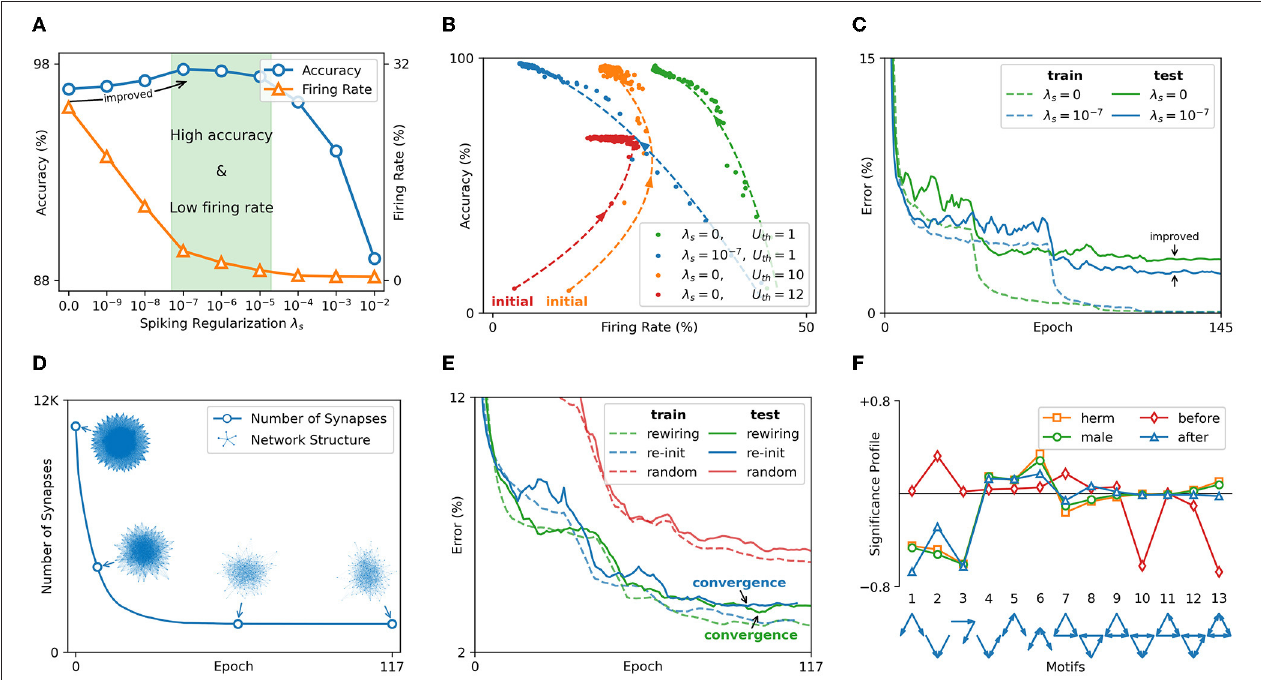
FIGURE 8 | (A) The test accuracy and FR under different spiking regularization coefficients λ s . (B) Accuracy and FR change law in the learning process. (C) Learning curves under different λ s (after smoothing filtering). (D) The number of synapses and network structure changes in the recurrent layer. (E) The learning curve with and without rewiring mechanism (after smoothing filtering). (F) Significance profile of C. elegans nervous system and the gas sensor network.